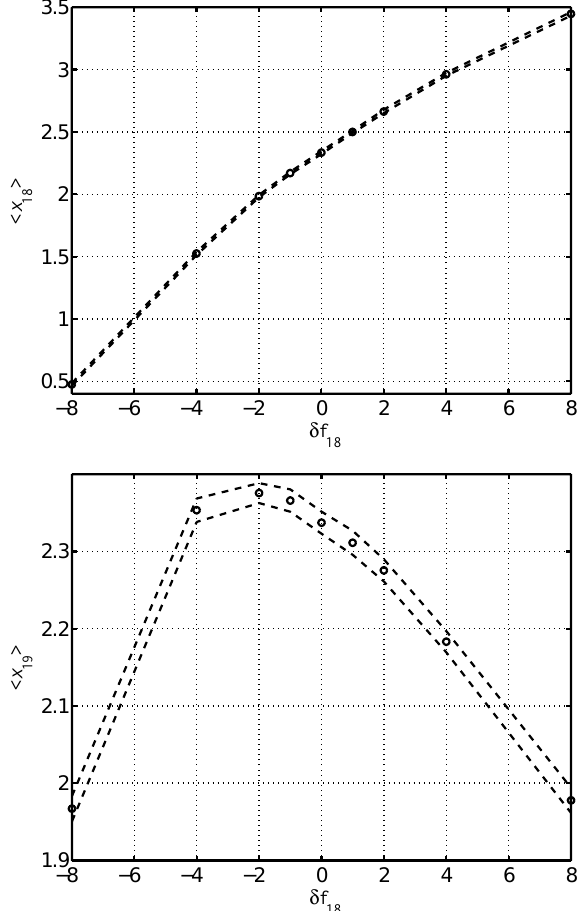
Fig. A1. The mean value of state vector element x 18 and x 19 of a 36-element Lorenz 95 system as a function of forcing applied to x 18 to illustrate the range of linearity of the response. The dashed lines indicate two standard deviations divided by the square root of the number of independent integrations (of which there are 10). Plots of the response of other vector elements or of the elements of a 72-element or stochastic Lorenz 95 system yield similar ranges of linearity with different gradients near the